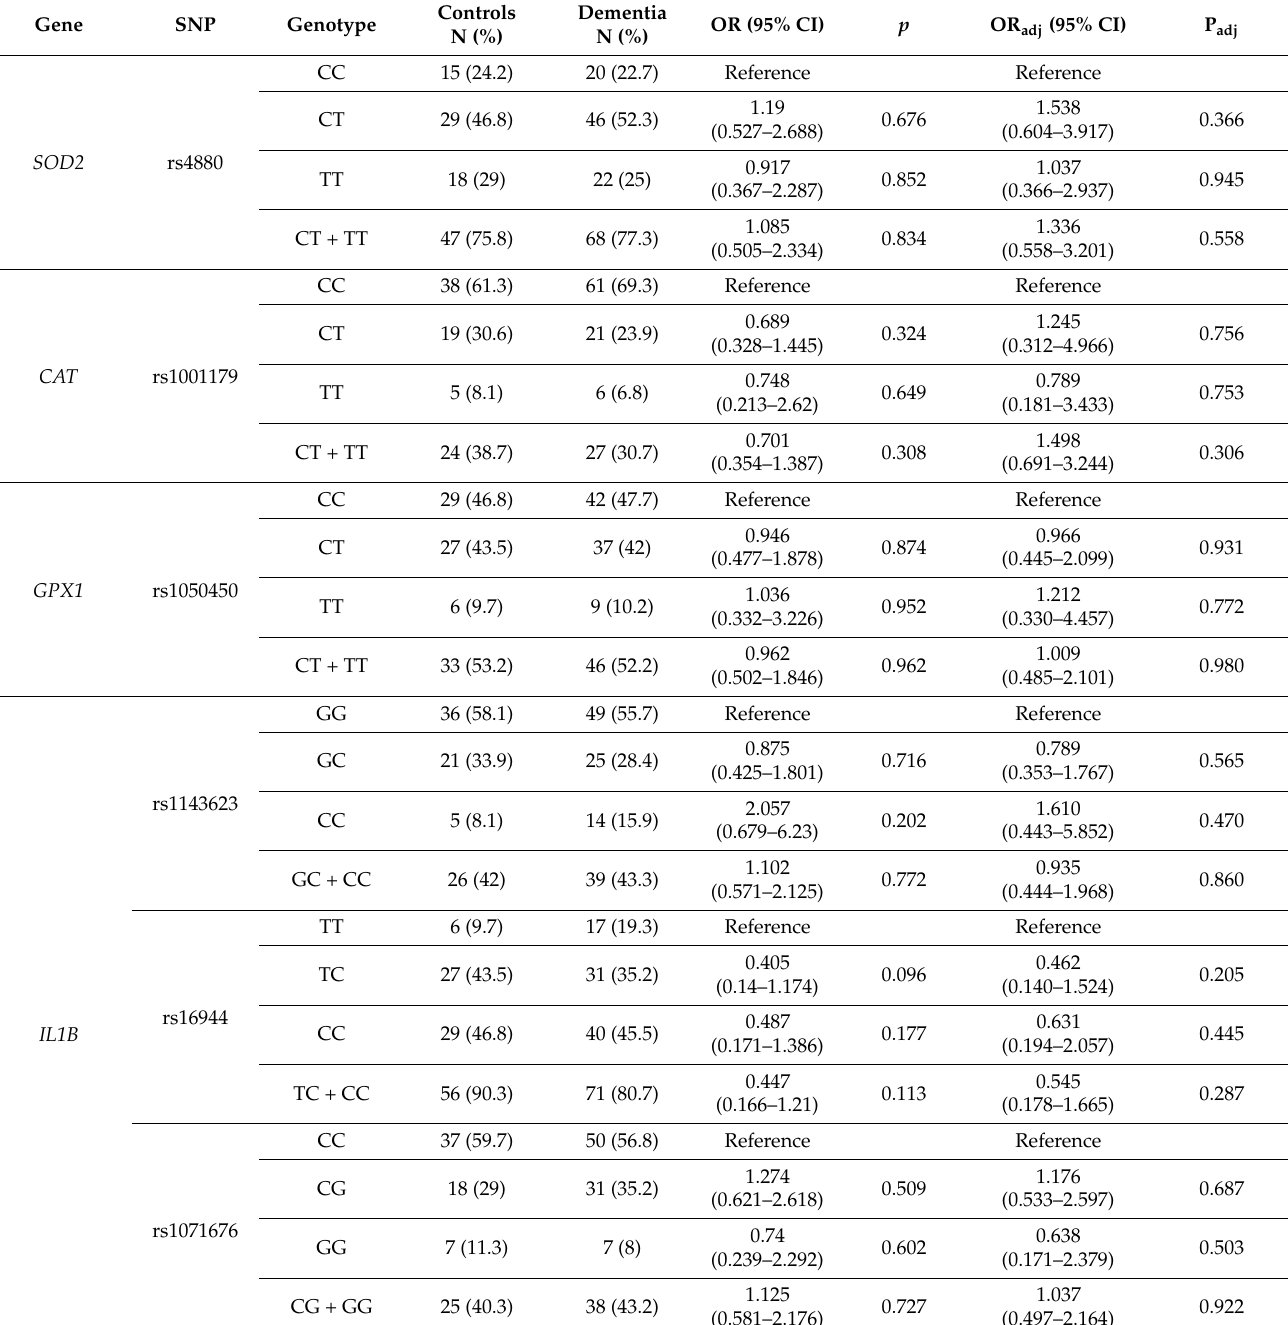
Table 2. Comparison of genotype frequencies among patients with dementia and